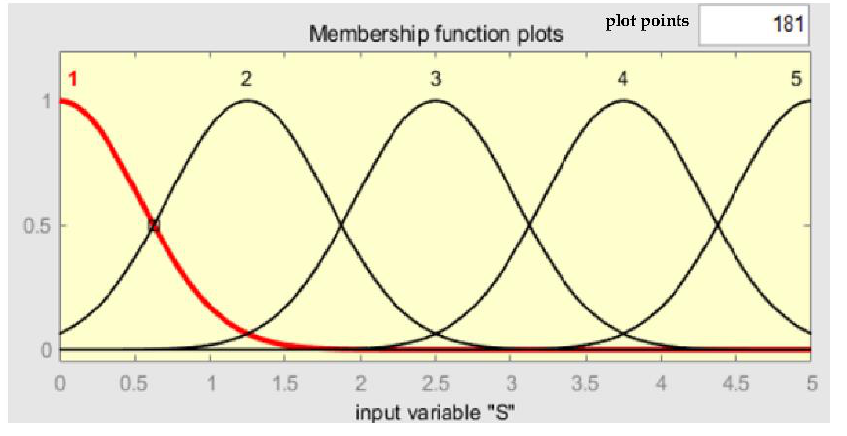
Figure 3. Membership function editor.